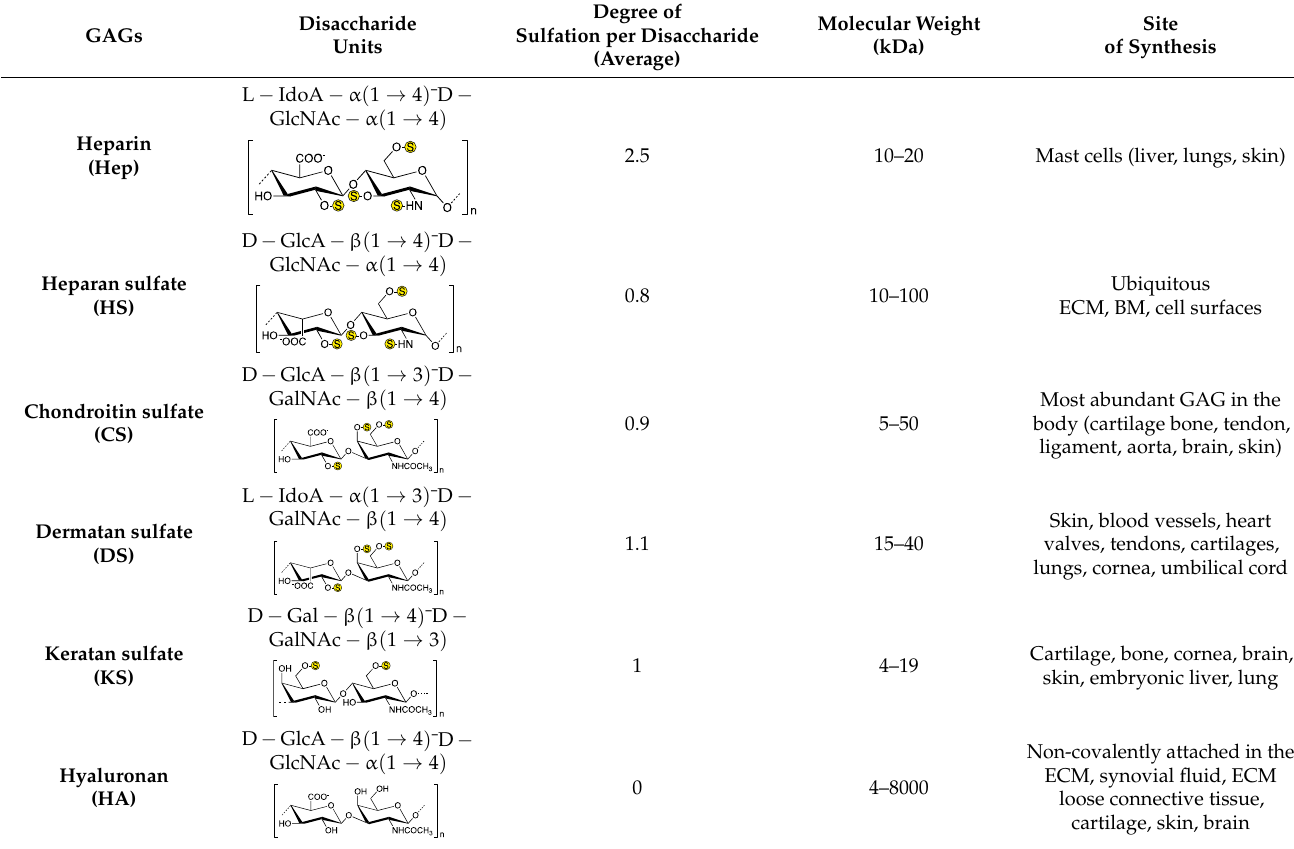
Table 2. General characteristics of GAGs (adapted from [41,42]).